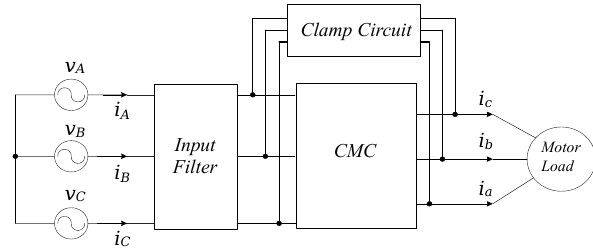
Figure 21. CMC converter with filter and clamp